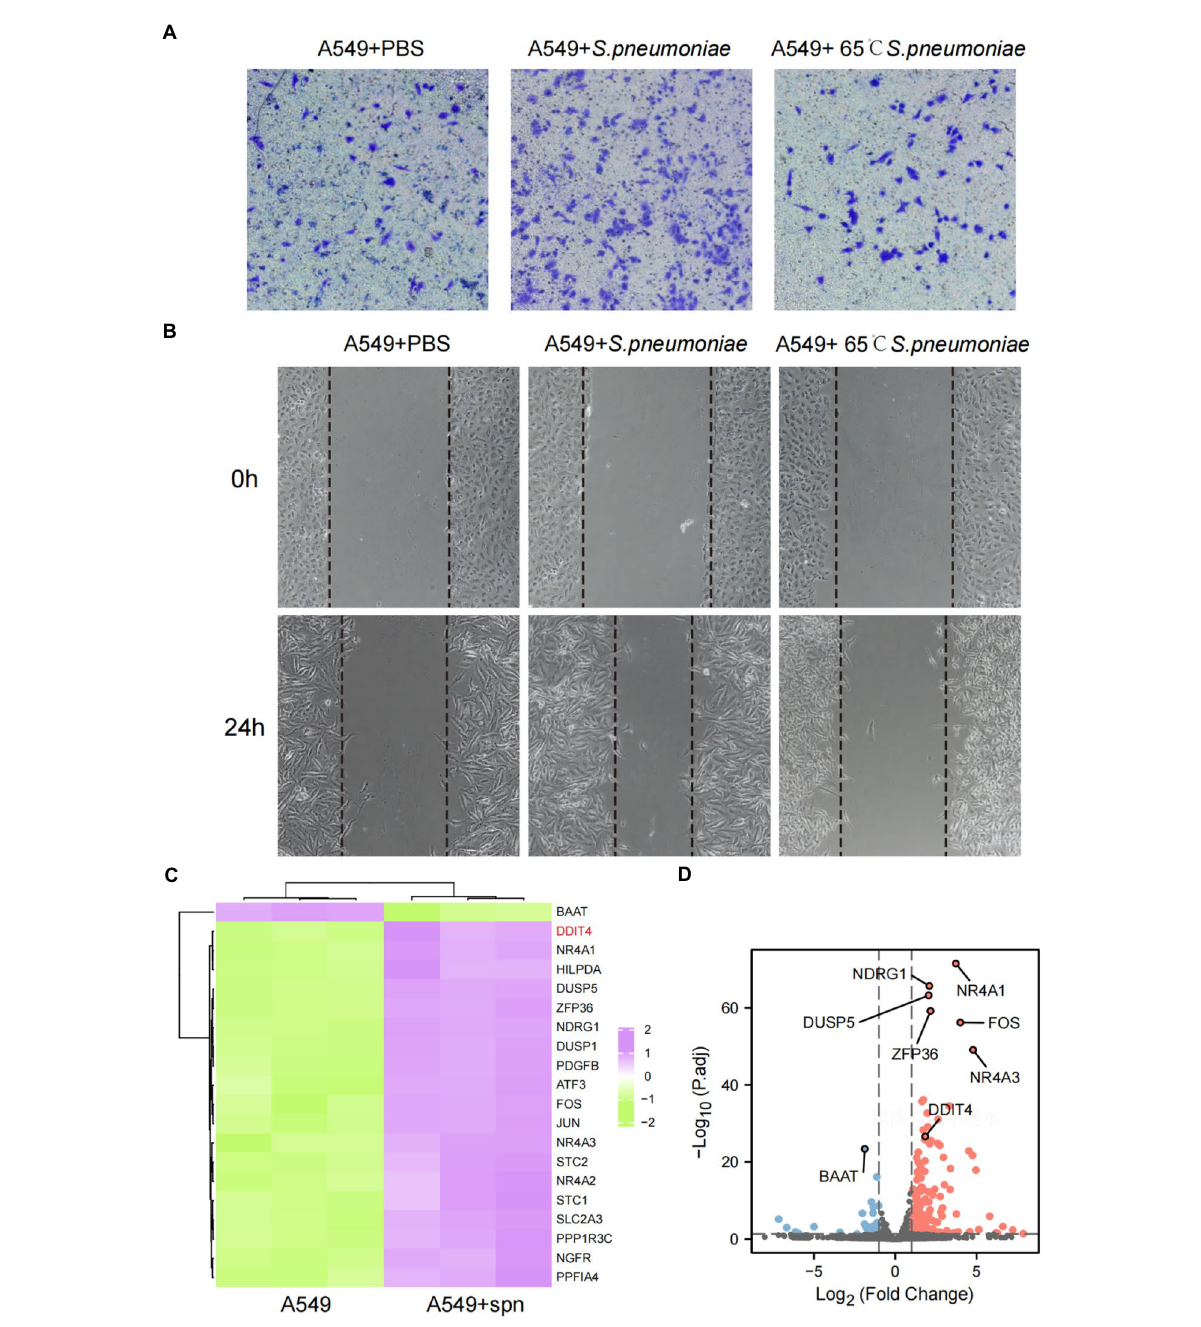
FIGURE 3 Enhanced migration and invasive abilities of A549 cells and transcriptome changes after infection with S. pneumoniae . (A) Transwell migration assays of A549 cells co-cultured with PBS, live S. pneumoniae , and heat-killed S. pneumoniae , respectively. (B) Cell scratch assays of A549 cells co-cultured with PBS, live S. pneumoniae , and heat-killed S. pneumoniae for 0 and 24 h, respectively. (C) Compared with the control group, the top 20 mRNAs with the most significant changes after co-culture of A549 cells with S. pneumoniae . (D) Volcano plot of significantly different